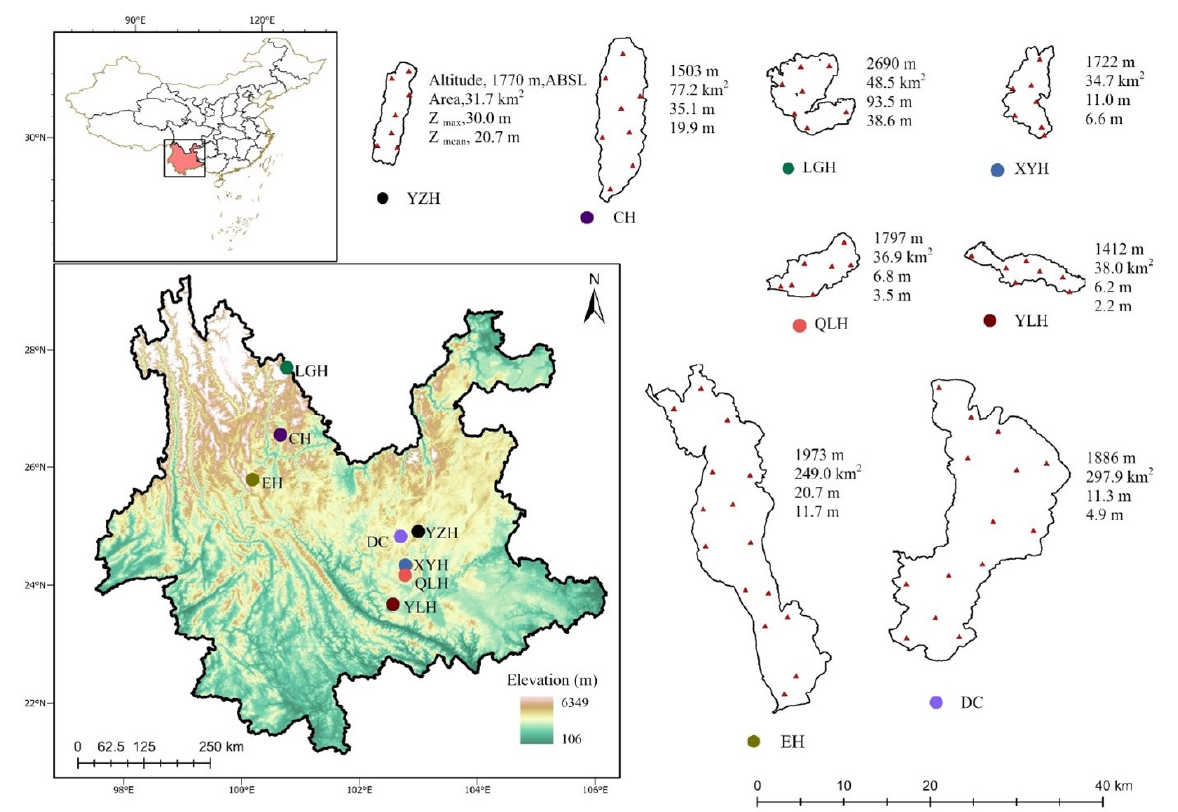
Figure 1. Location and sampling sites of the studied lakes. Lake Luguhu, LGH; Lake Chenghai, CH; Lake Yangzonghai, YZH; Lake Erhai, EH; Lake Xingyunhu, XYH; Lake Dianchi, DC; Lake Yilonghu, YLH; and Lake Qiluhu. QLH.